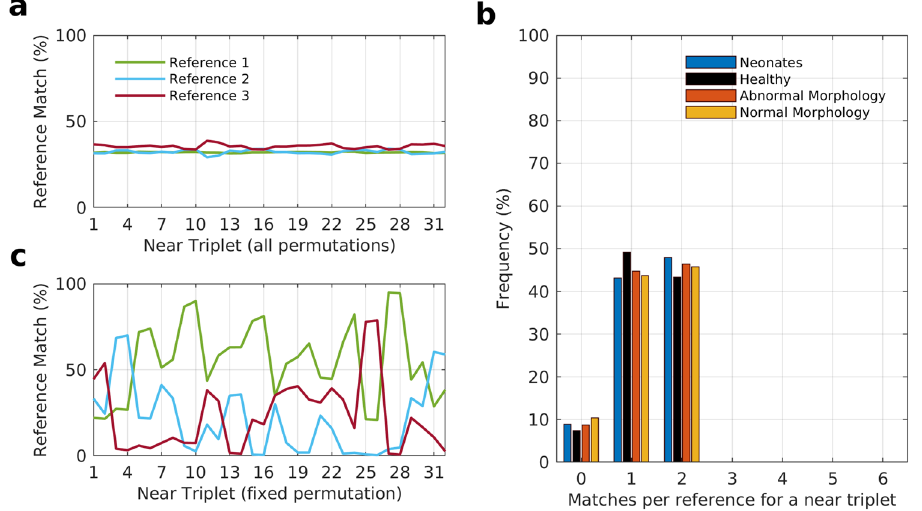
Figure 5. The prevalence of the three reference patterns relative to each other in the near set of triplets. ( a ) The percentage frequency with which each of the three references are observed across all permutations of a triplet (near) in data sets 2–4. The connectivity patterns of all six permutations at each triplet location that gave a statistically significant match were selected from the three data sets. The particular reference out of three that each pattern best matched with was noted and is shown as percentage frequency for all the three data sets. ( b ) Histogram for the number of permutations, among the six available per triplet, that matched with each of the three references. All three references are represented in this single histogram. A reference can match with anywhere between zero to all six permutations of a triplet. The histogram was constructed for a total of 77,120 triplets across all EEG records in data sets 2–4. ( c ) The percentage frequency with which each of the three references is observed in a fixed permutation of a triplet (near) across data sets 2–4. A particular permutation out of the six available for each triplet was arbitrarily chosen and kept fixed, unlike a where all six permutations were